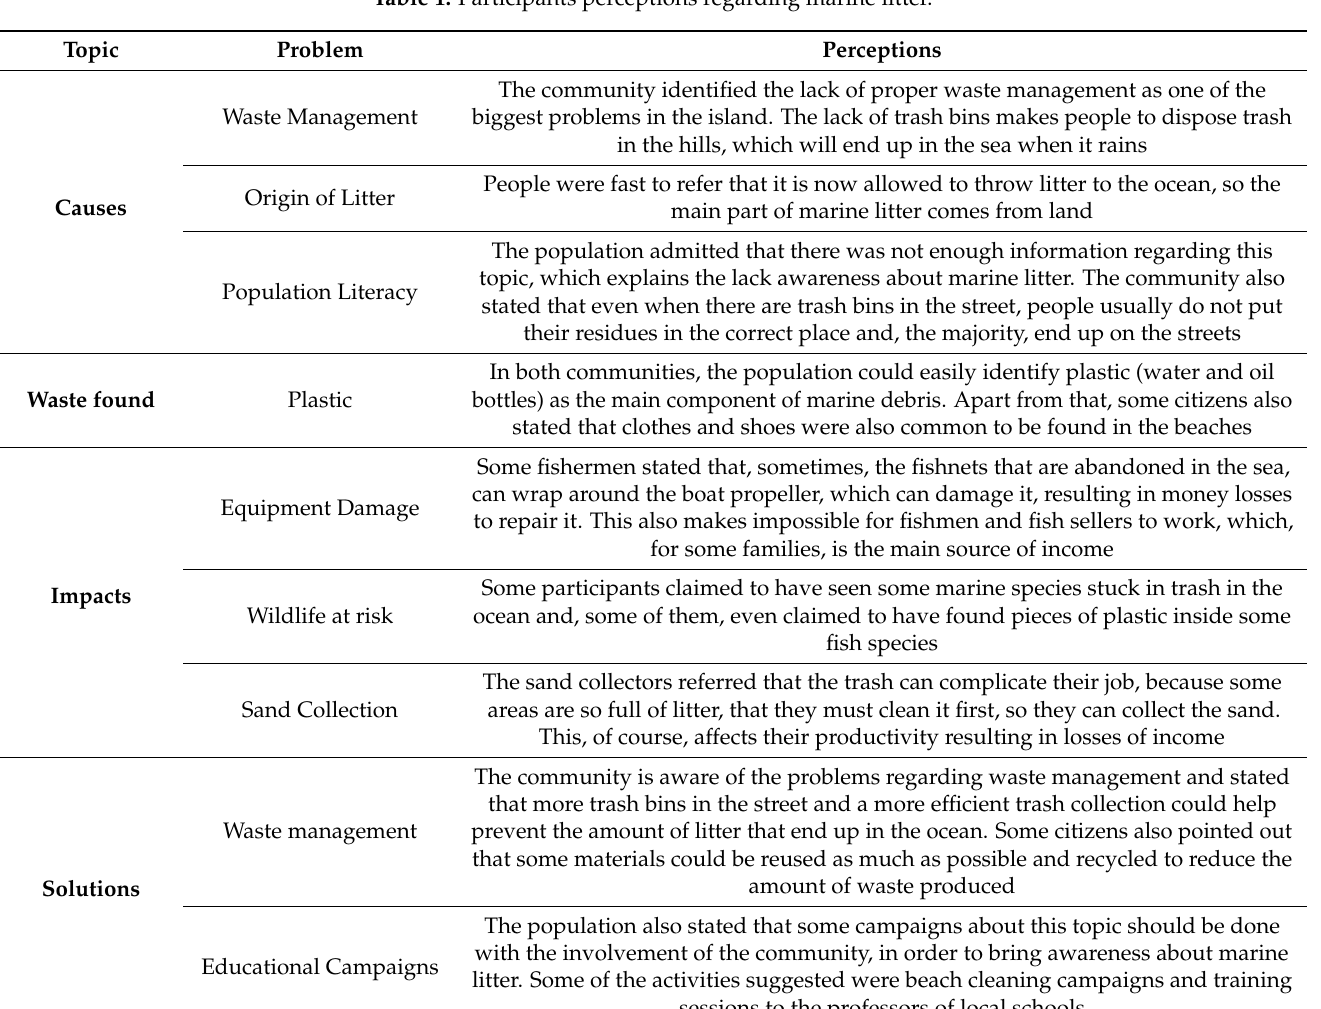
Table 1. Participants perceptions regarding marine